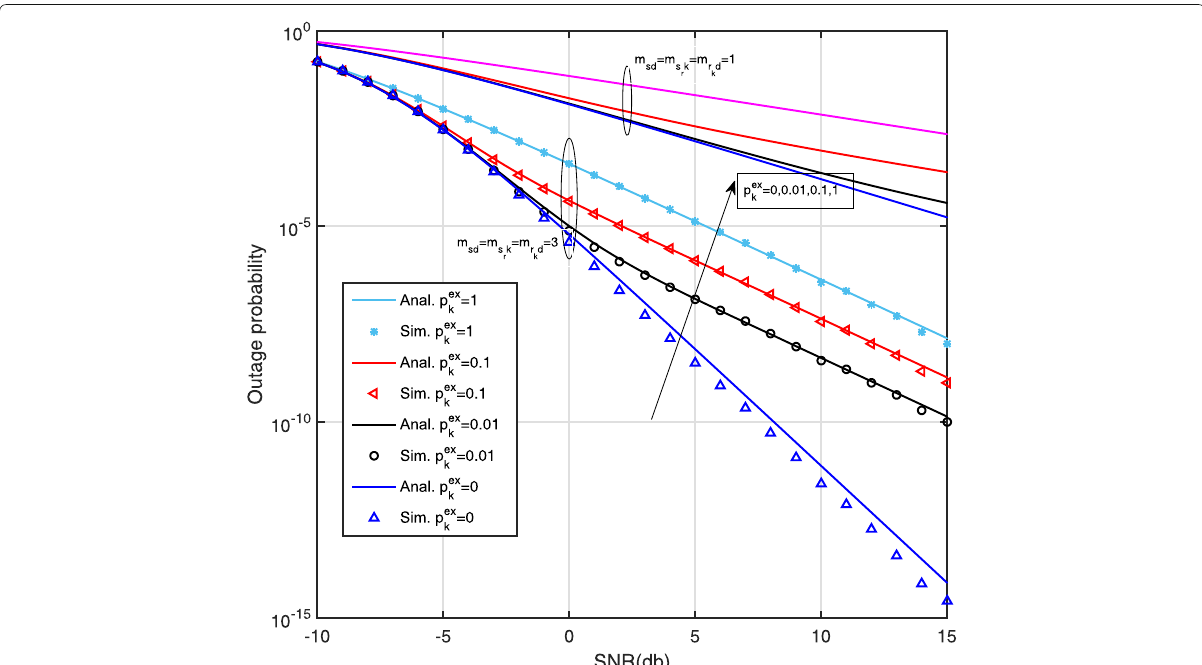
= 3, m = 3, p ex = { 0,0.01,0.1,1 } , and k = r k d 1 r k